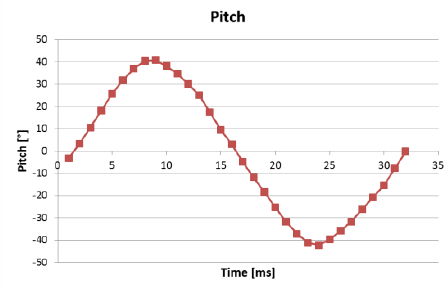
Fig. 4. Sine wave of pitch-time dependency, Ma = 0.45.